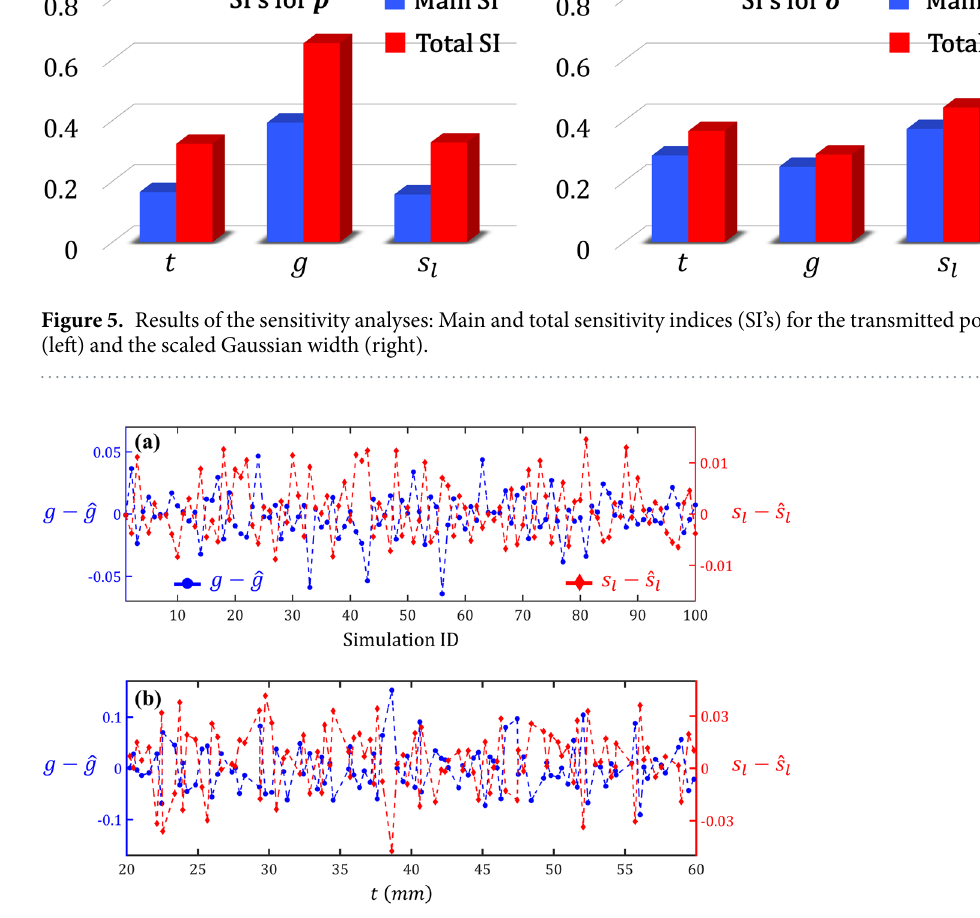
Figure 6. Errors in predicting the scattering properties of 100 tissue samples: The scattering properties of most samples have been estimated quite accurately. In ( a ) and ( b ) the simulations are ordered with respect to, respectively, simulation number and the sample